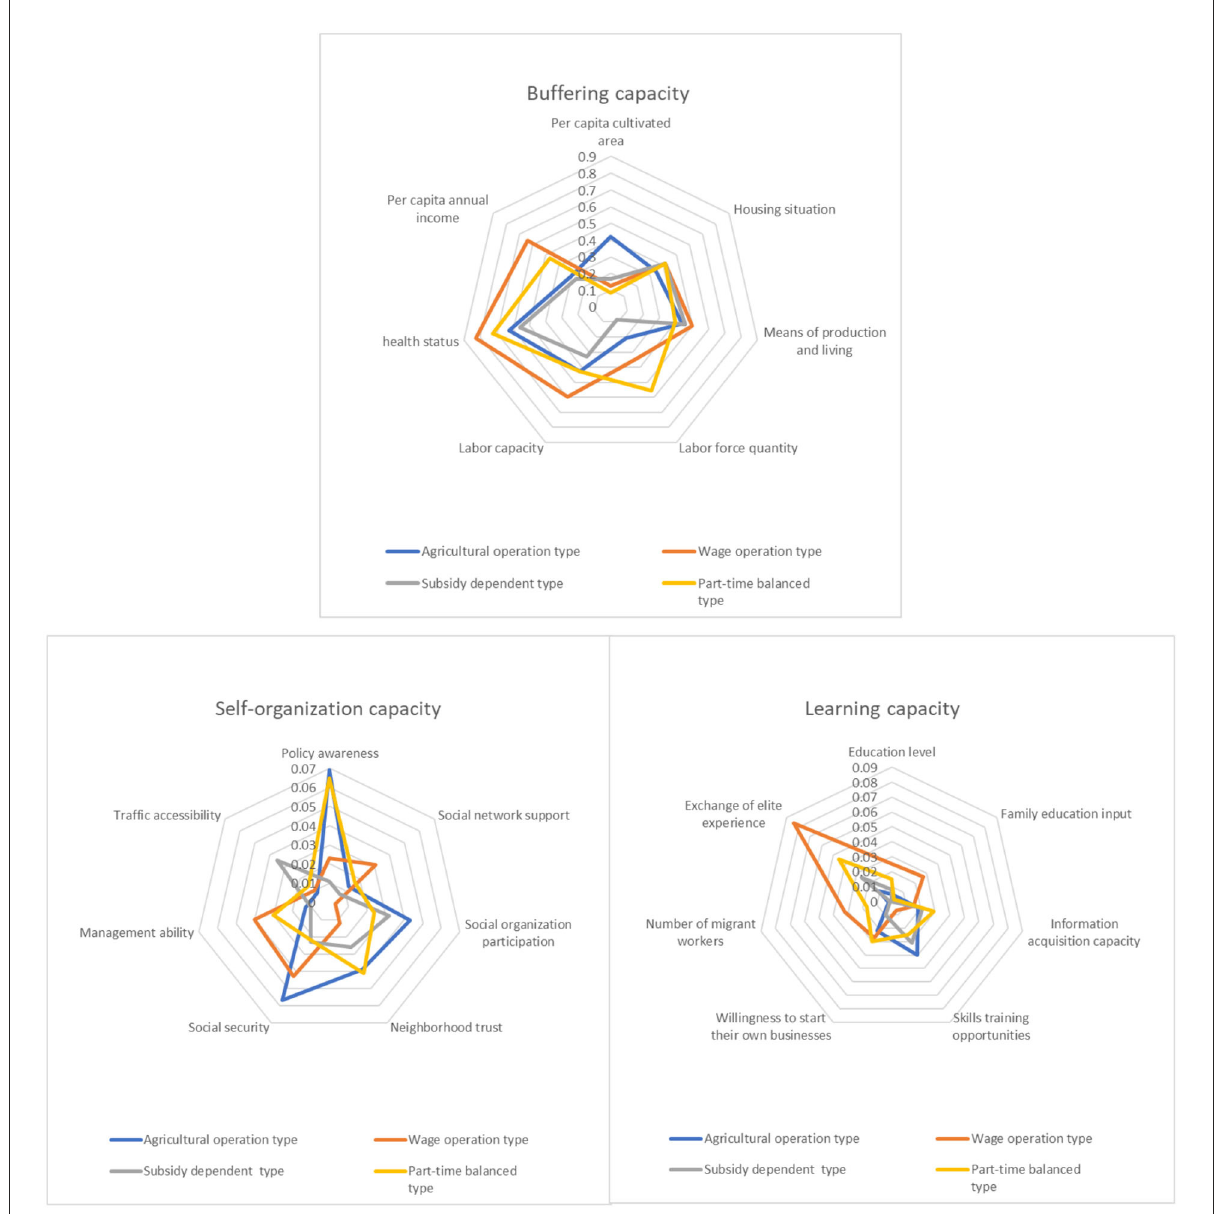
FIGURE1 Scores of various dimensions of resettled households’ livelihood